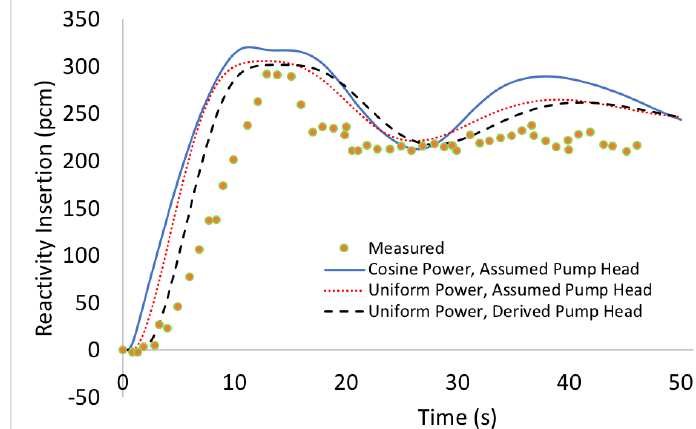
Figure 5. SAM results vs experimental measurements for the pump startup